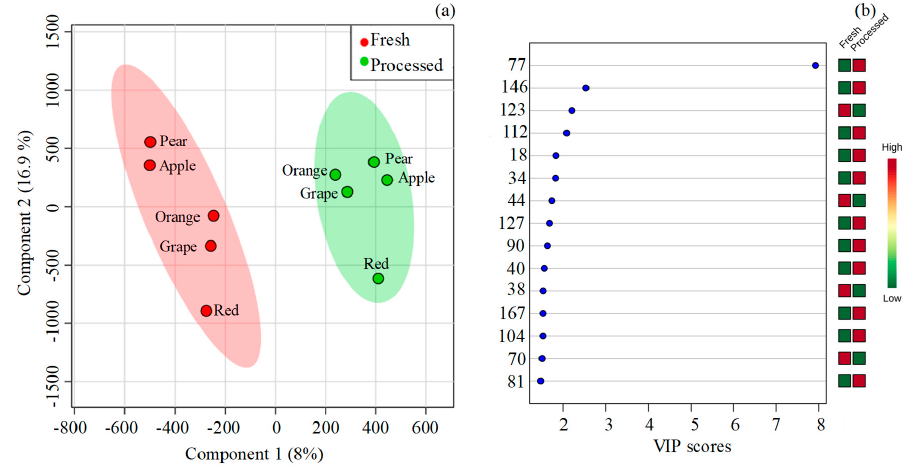
Figure 4. Partial least squares-discriminant analysis (PLS-DA) of the volatile signature of fresh and processed fruit juices. ( a ) Score scatter plot, and ( b ) Variable importance in projection (VIP) scores (attribution of the peak number is shown in Table 1).